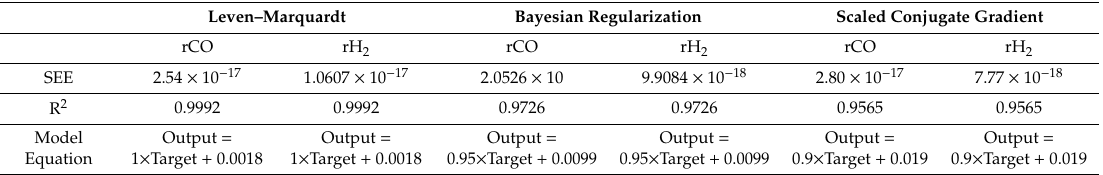
Table 3. Statistical analysis of the ANN modeling using di ff erent